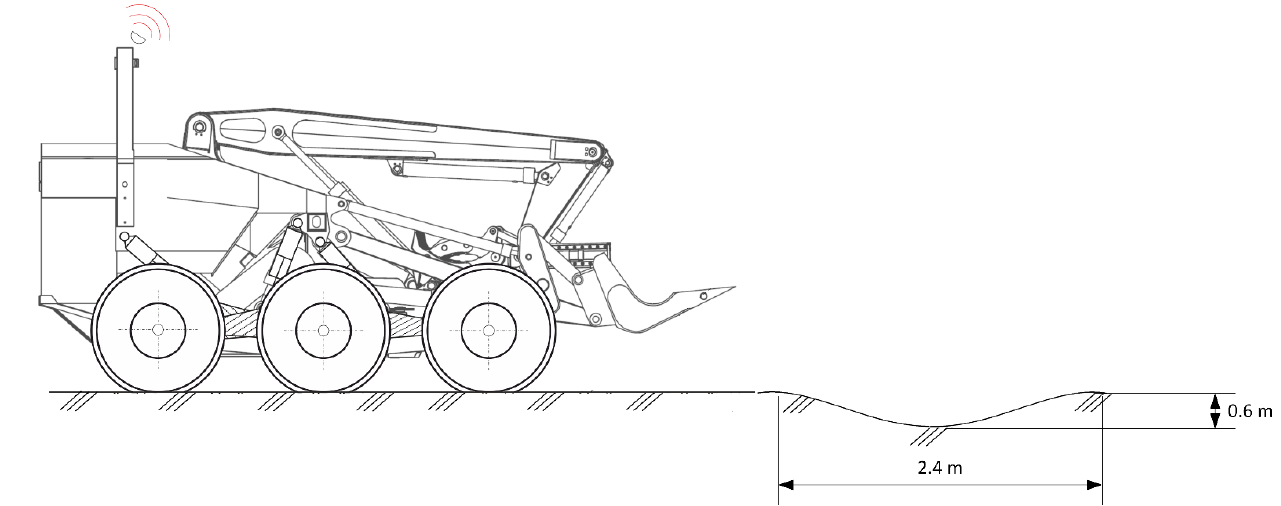
Figure 12. Overall scheme of simulated situation.